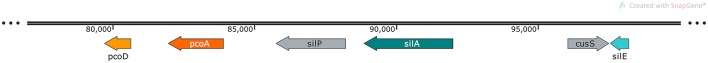
Location of pcoA, pcoD, silA, and silE in the identified genomic region. SilP and cusS are also represented in gray, since they were searched after functional annotation highlighted them as conserved in all samples carrying the pcoA-pcoD-silA-silE HMTG profile.